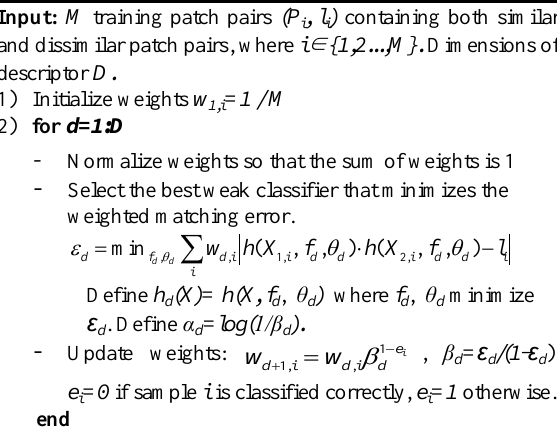
Algorithm.1. AdaBoost training descriptors